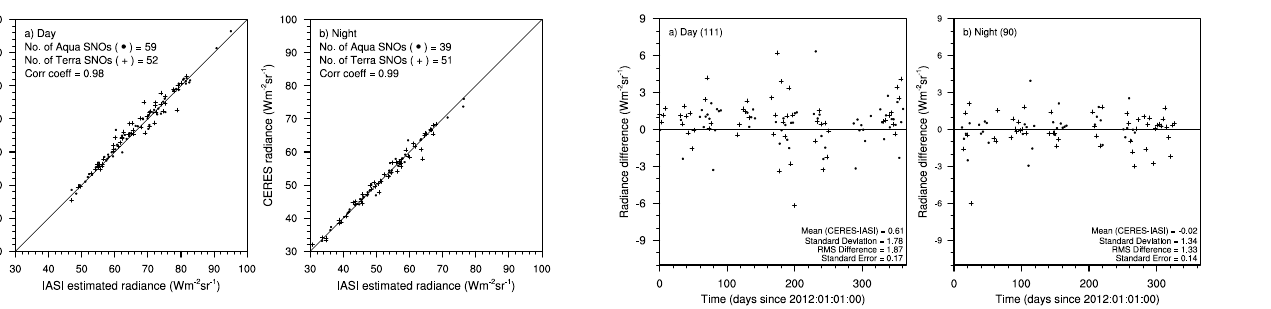
Figure 9. Absolute values of INLR constructed from IASI on Metop-A against CERES measurements for both the Terra and Aqua satellites at the closest SNO events in 2012 for (a) day and (b) night.